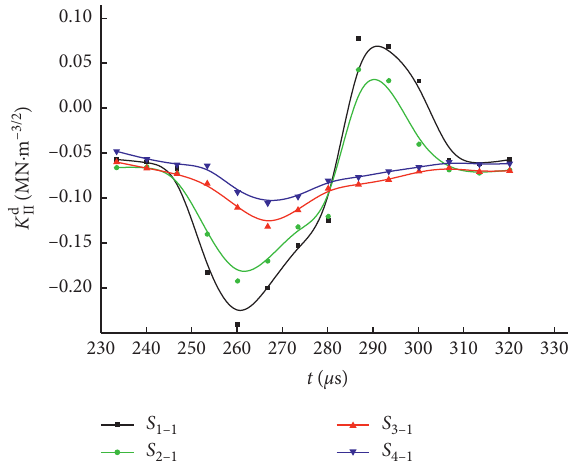
Figure 11: Mode II stress intensity factor curves with